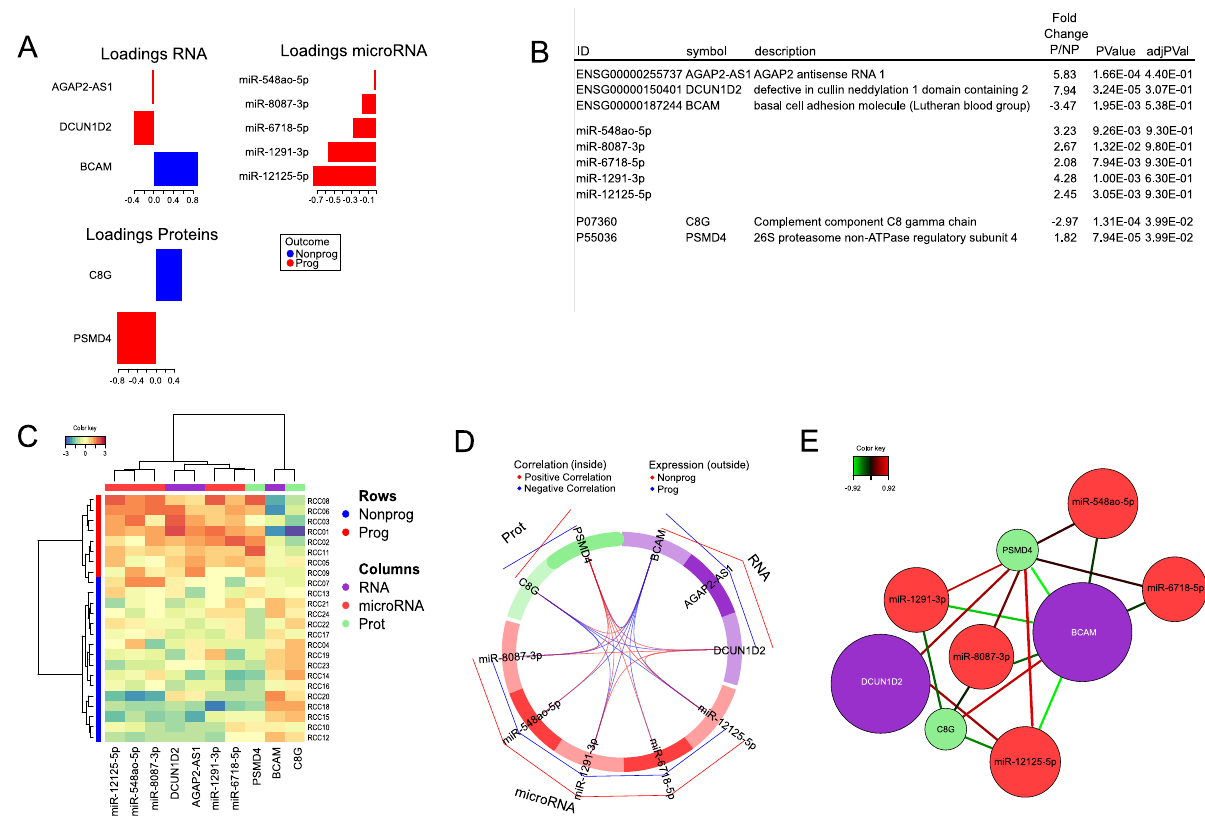
Figure 4. Disease progression signature. For the visualization of the molecular signature, the loading plot ( A ) represents the loading weights of each variable on component 1 of the multivariate model. Most important variables, according to absolute values of their coefficients) are ordered from bottom to top. Colors indicate the class for which the mean expression value is the highest or the lowest for each feature. In ( B ), the features of the model are shown, listed according to the loading plot in ( A ). In ( C ), the Clustered Image Map (CIM) demonstrates that the expression values of the 10 features of the model yield two clusters of samples (rows) and two main clusters of over- and underrepresented features, by employing Euclidian distance and Ward´s linkage. ( D ) Pearson correlation of the expression values of the features, as visualized by a circosplot, with cutoff 0.07. Positive correlation in red, negative in blue. The outer lines indicate whether the featured marker is expressed to a higher (red line) or lower (blue line) extent in NP, as compared to P. The Relevance network in ( E ) demonstrates the correlation structure between variables shown in ( D ) (cutoff 0.7), where positive correlation is depicted in red and negative correlation in blue. The similarity value between a pair of variables is obtained by calculating the sum of the correlations between the original variables and each of the latent components of the